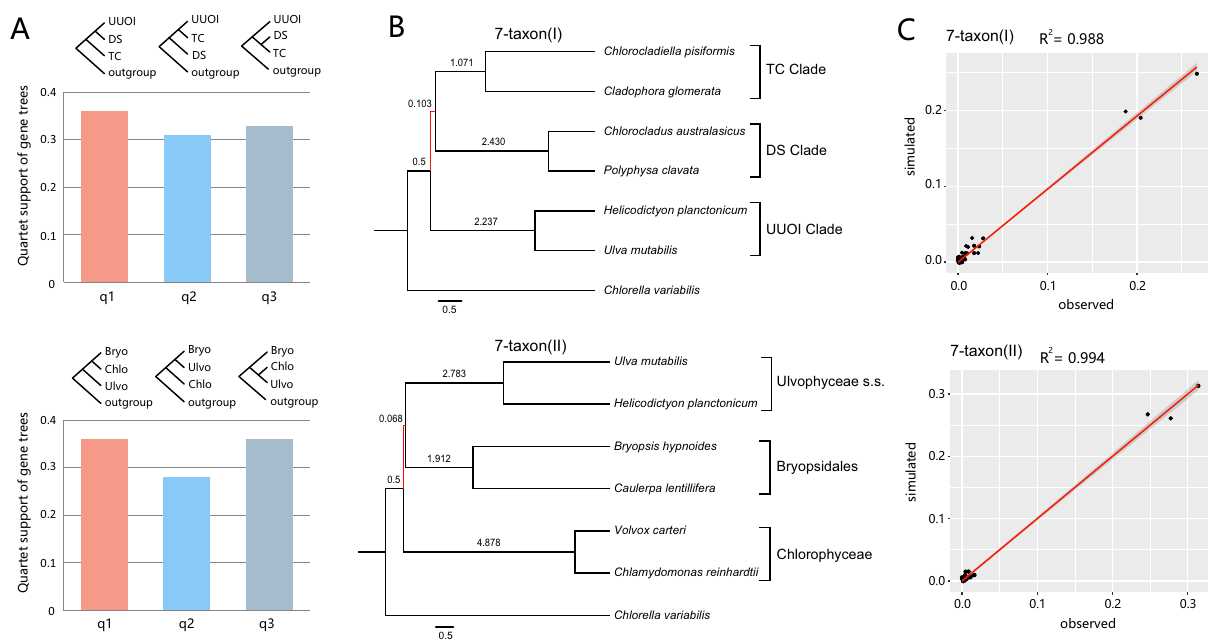
Fig. 3 Gene tree discordance and coalescent simulations. A The frequency of three topologies (q1 – q3) around two short internal branches of ASTRAL species tree in the 69-taxon datasets. Each short internal branch with four neighboring branches leads to three possible topologies. B Phylogenetic relationships of 7-taxon(I) and 7-taxon(II) datasets based on the multispecies coalescent model. Red branches are the short branches. C Comparison of simulated frequencies of gene tree topologies with the corresponding observed frequencies. Bryo Bryopsidales, Chlo Chlorophyceae, Ulvo Ulvophyceae